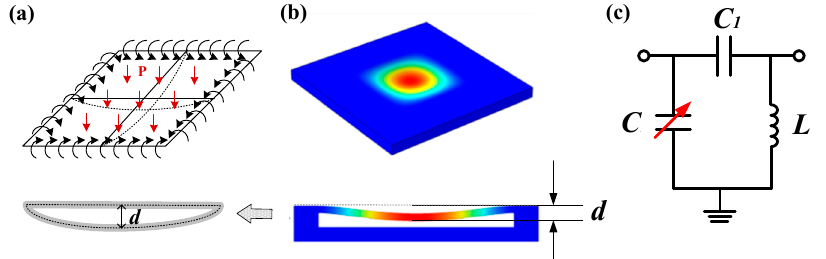
Figure 2. Sensor pressure detection mechanism. ( a ) The mechanical model with edges-fixed rectangular cavity with uniformly distributed load. ( b ) The stress distribution in COMSOL. ( c ) The equivalent circuit of the sensor.